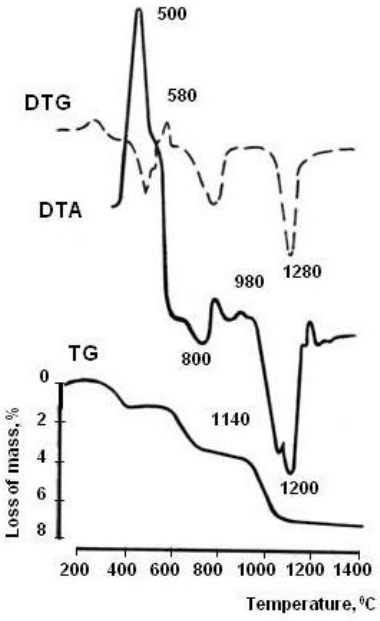
Figure 3. DTG pattern of WMS.